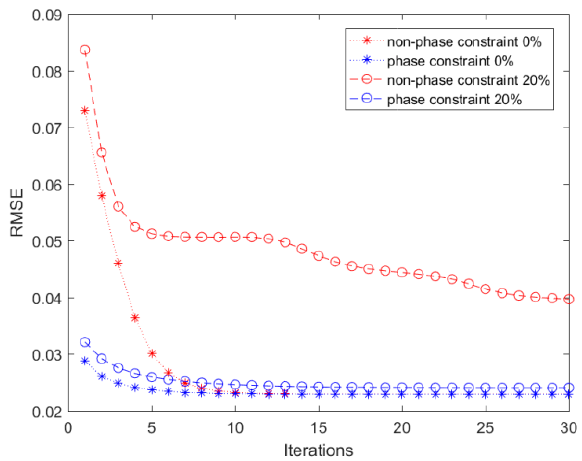
Figure 6. The root-mean-square error (RMSE) of our proposed method and the classic method without a phase constraint.